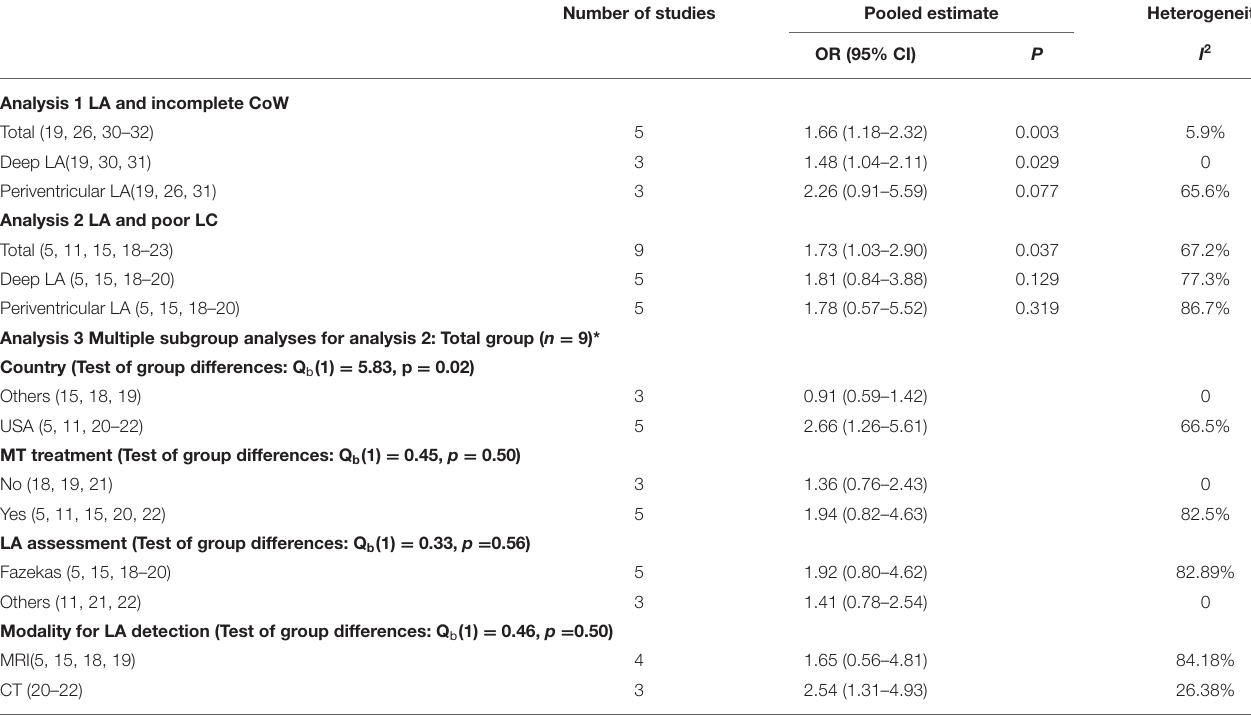
TABLE 2 | Main results about the association between LA and collateral status.